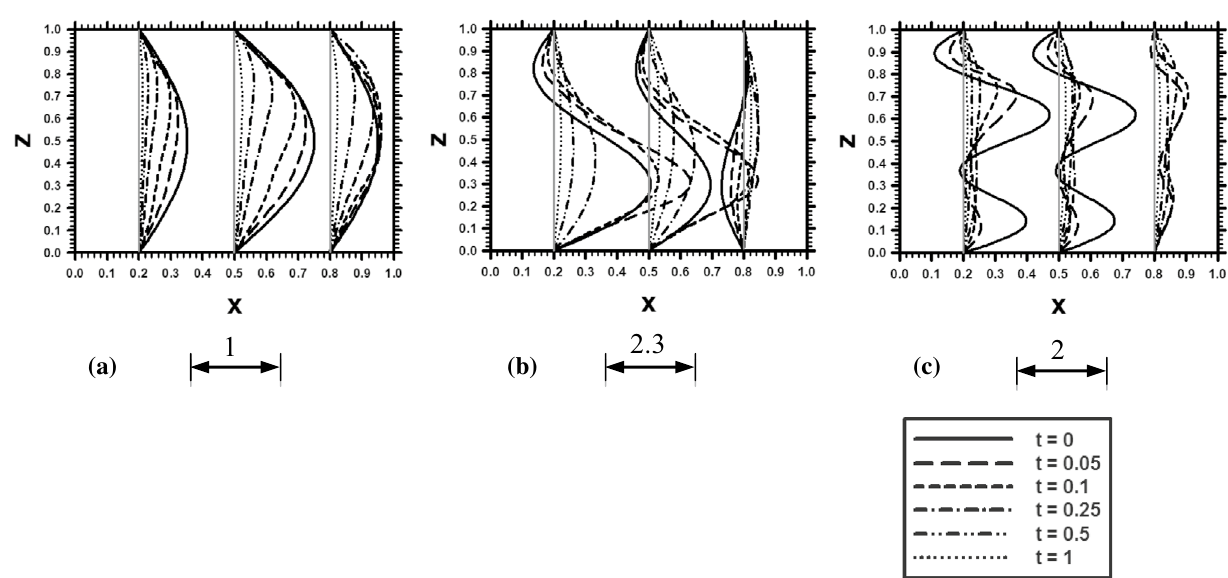
Fig. 4 A sample of distribution of the velocity of the a longitudinal ( u ), b depth ( v ) and c transverse ( w ) along the width and for passing plate 𝜐 through the middle of the depth ( = 0.05)